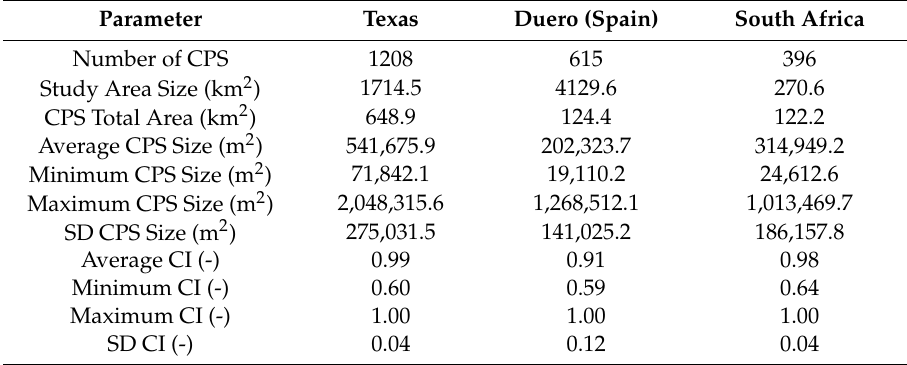
Table 1. Descriptive statistics of CPSs found in the three study areas, including the number of CPS; their total area and size; and their Compactness Index (CI) distributions in terms of average, minimum, maximum, and standard deviation (SD) of size and CI values found for the single